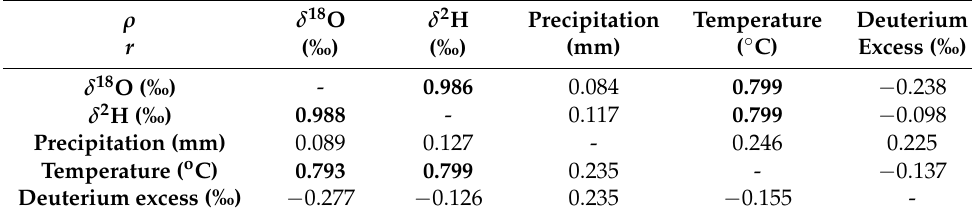
Table 1. Pearson’s r and Spearman’s ρ correlation coefficients.